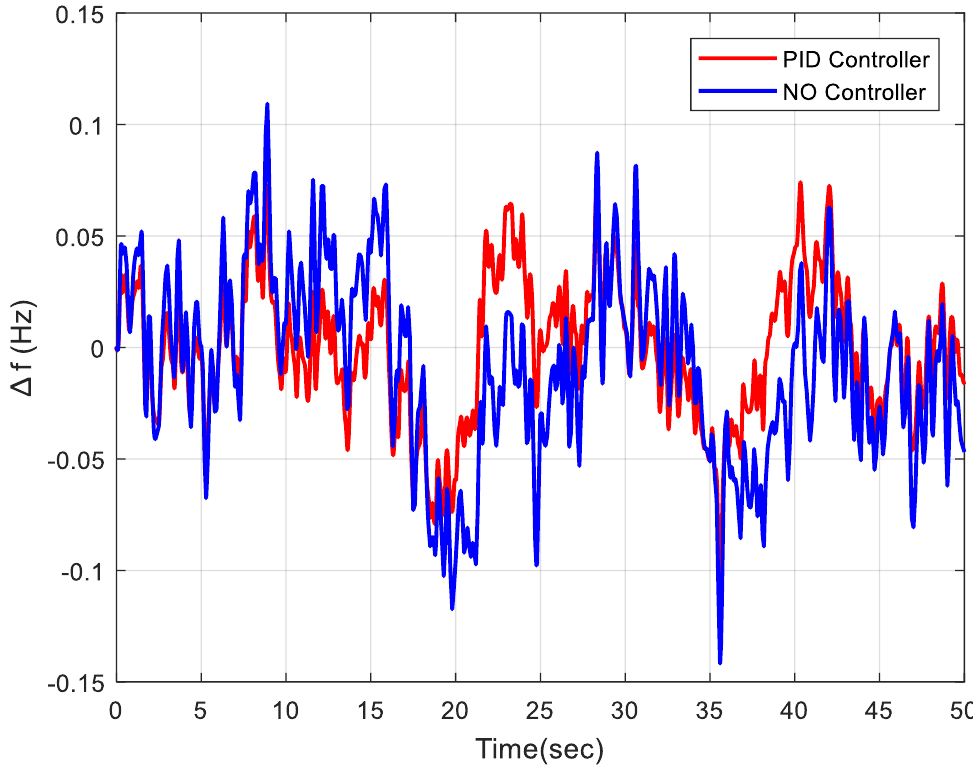
Figure 7. Frequency changes with and without a PID controller.